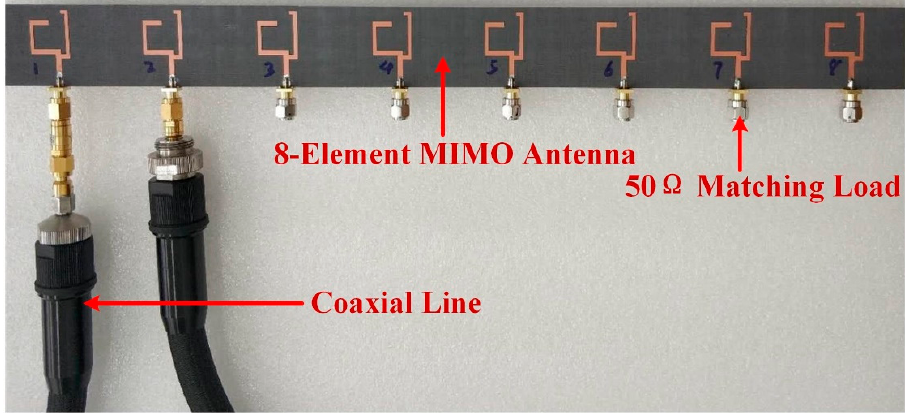
Figure 5. A photograph of the manufactured eight-element MIMO antenna.